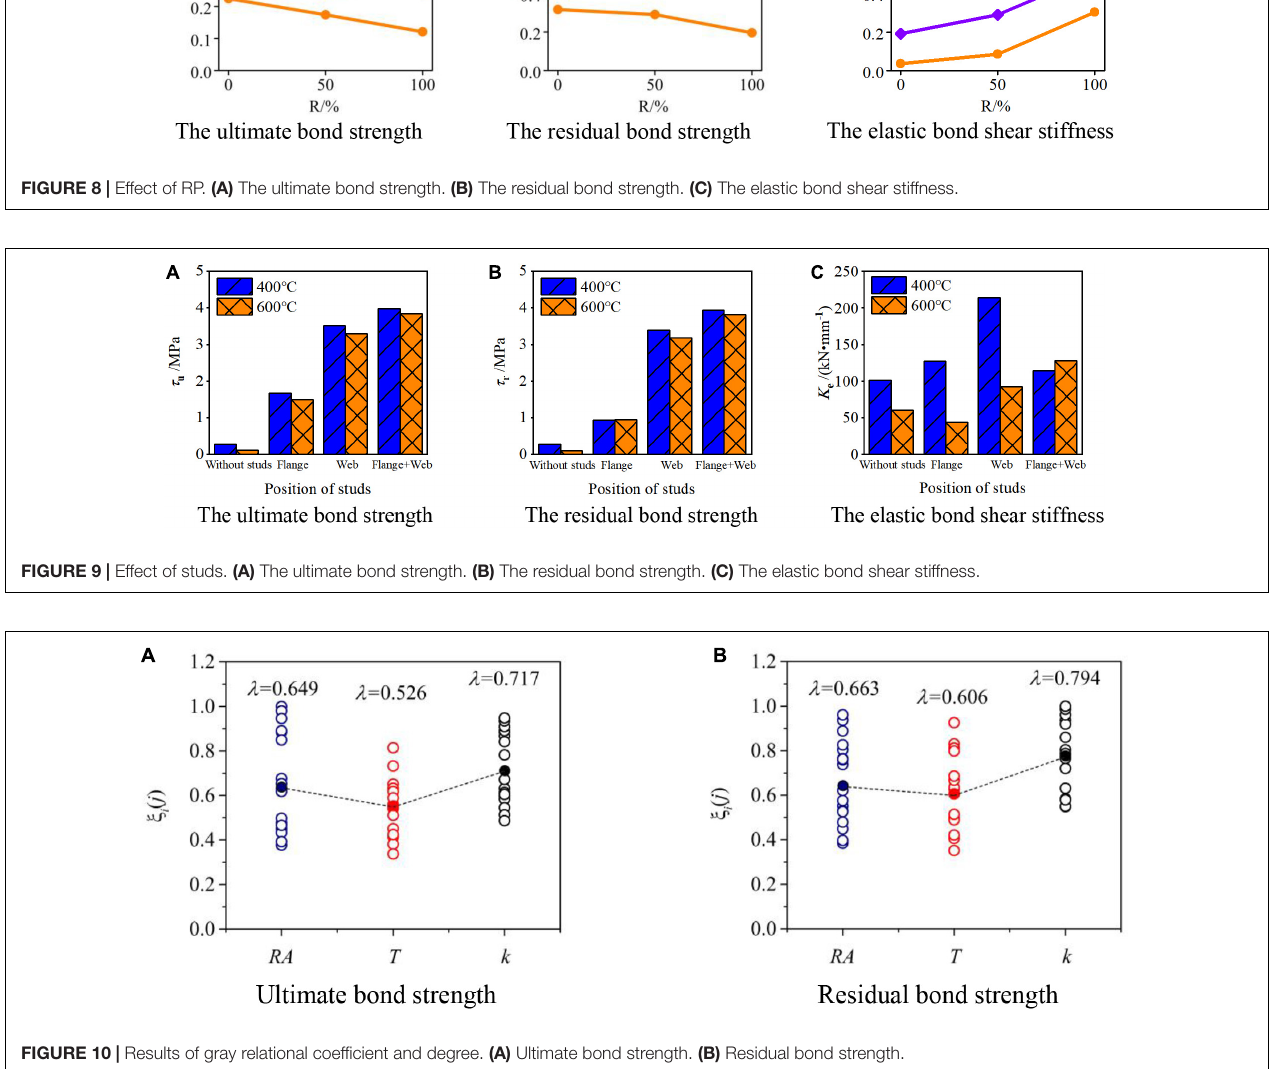
Frontiers in Materials |